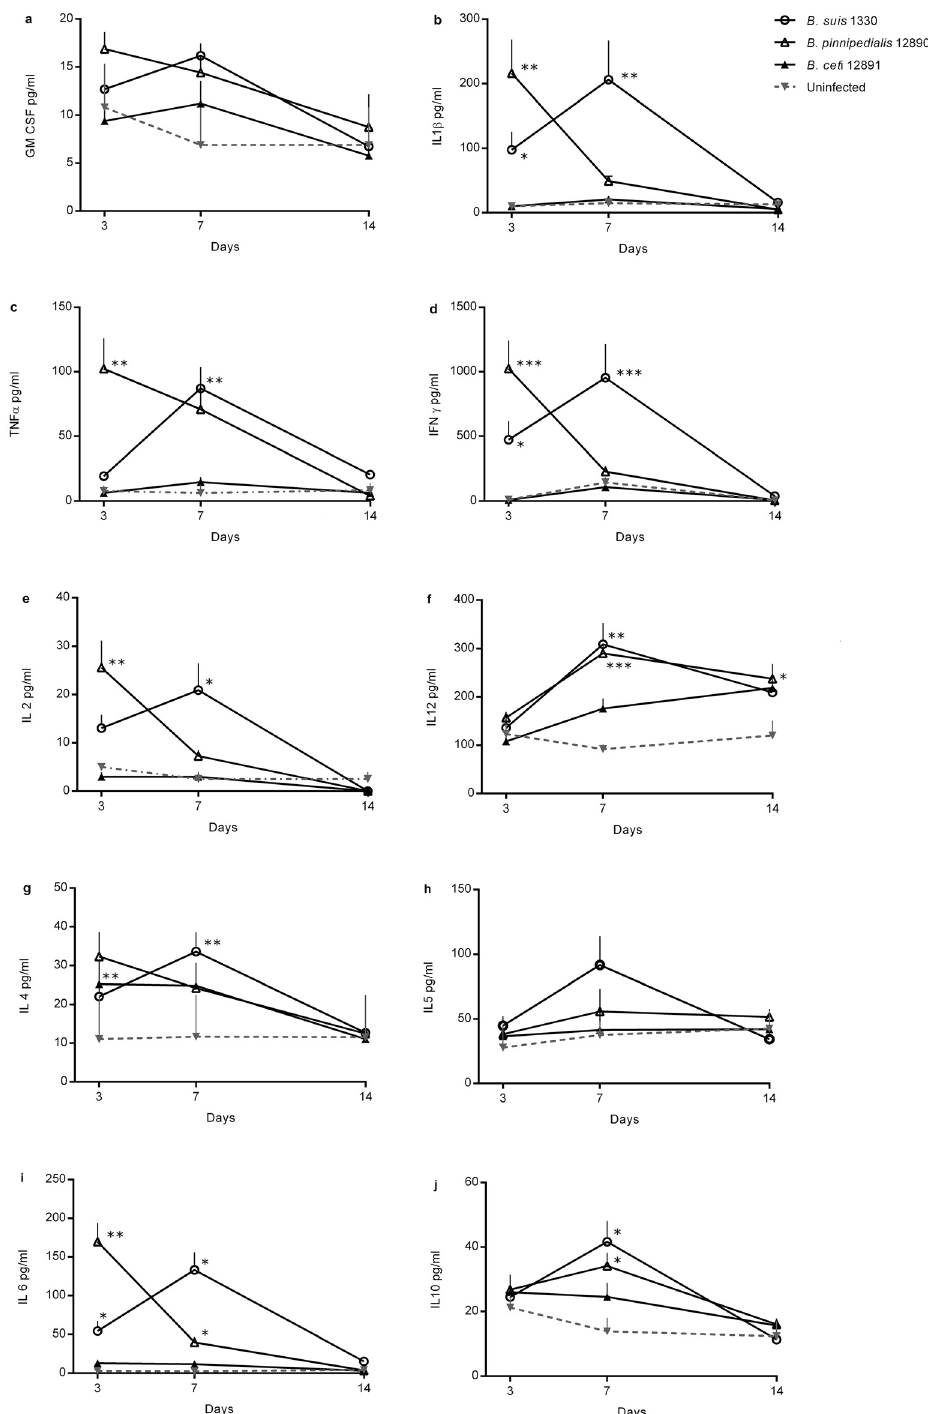
Fig 3. Serum cytokines. Serum levels of granulocyte-macrophage colony-stimulating factor (GM-CSF) (a), interleukin (IL)-1 β (b), tumor necrosis factor (TNF)- α (c), interferon (IFN)- γ (d), IL-2 (e), IL-12 (p40/p70) (f), IL- 4 (g), IL-5 (h), IL-6 (i) and IL-10 (j) in BALB/c mice, after intraperitoneal (ip) inoculation of 10 5 colony forming units (CFU) of B . pinnipedialis 12890, B . ceti 12891 or B . suis 1330. Uninfected mice received sterile phosphate buffered saline ip. Four or five mice were euthanized per lot at day 3, 7 and 14 post infection. Results are expressed as mean serum cytokine levels in pg/ml + one standard error of the mean. The marine mammal reference strains were compared to B . suis 1330 and *** = p < 0.001, ** = p < 0.01, * = p <